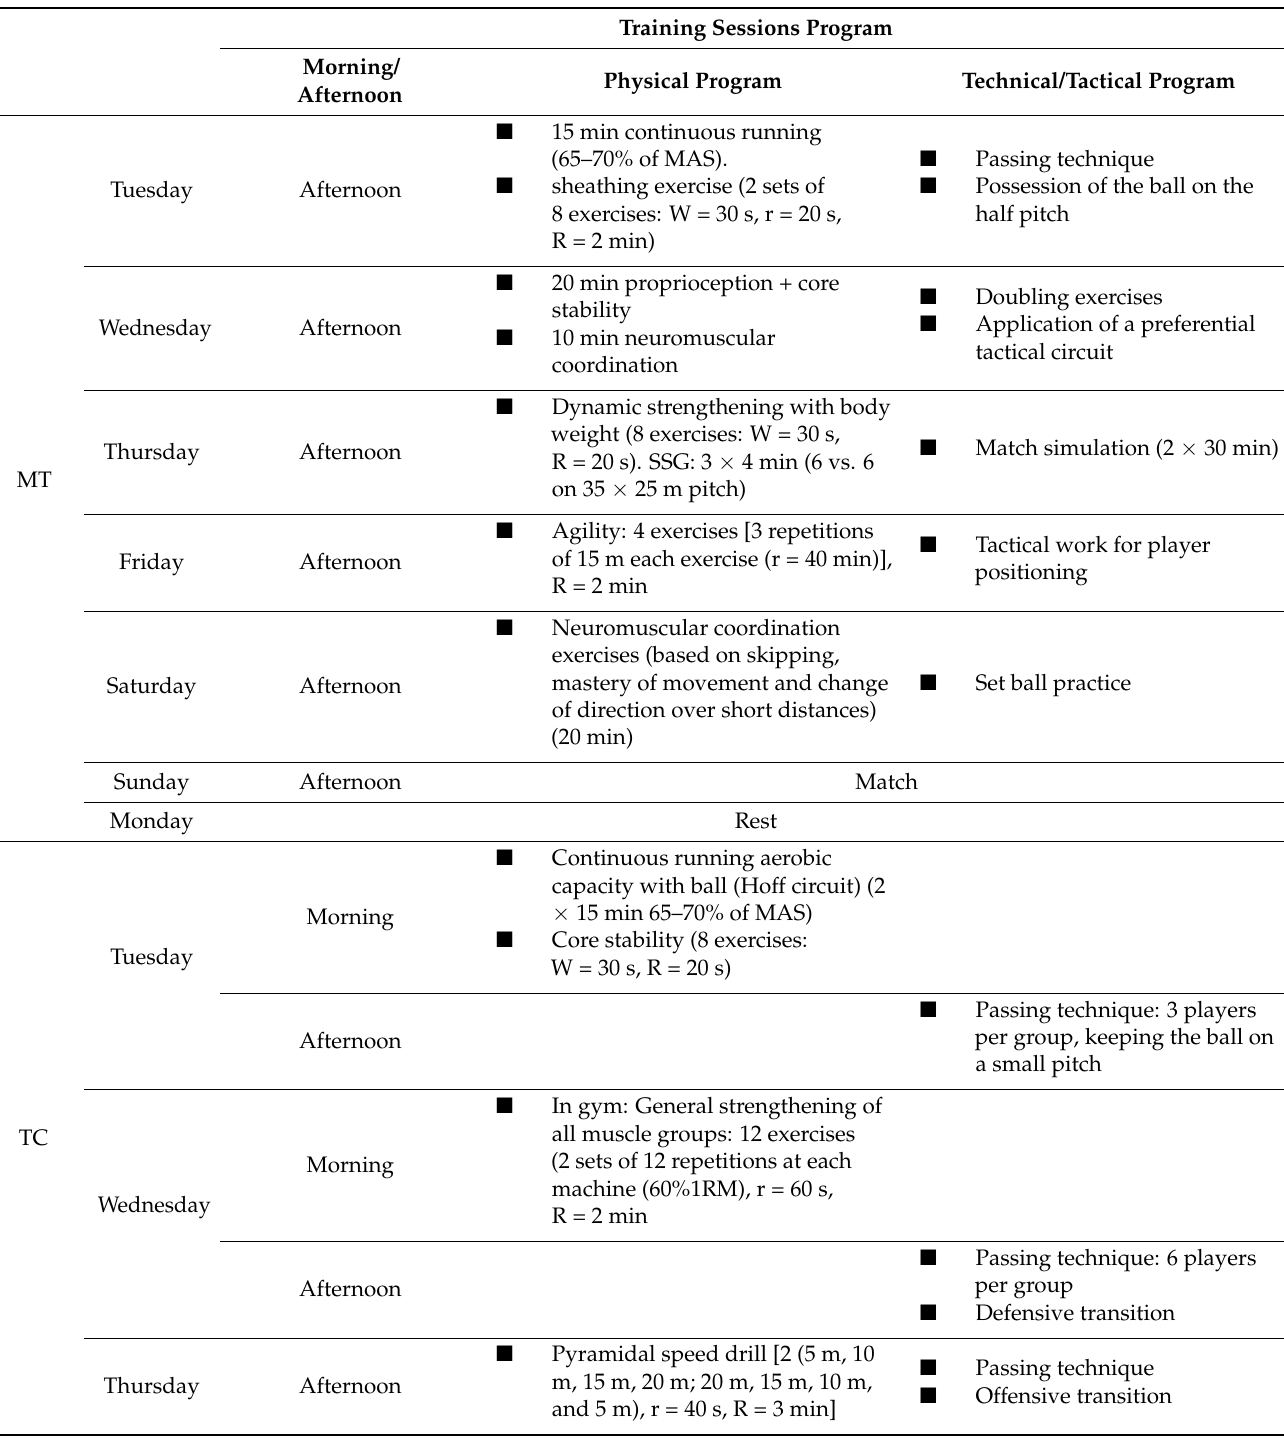
Table 2. The details of the training program carried out during the moderate training load week (MT) and intensified training camp (TC). MAS: maximal aerobic speed, W = work, R =